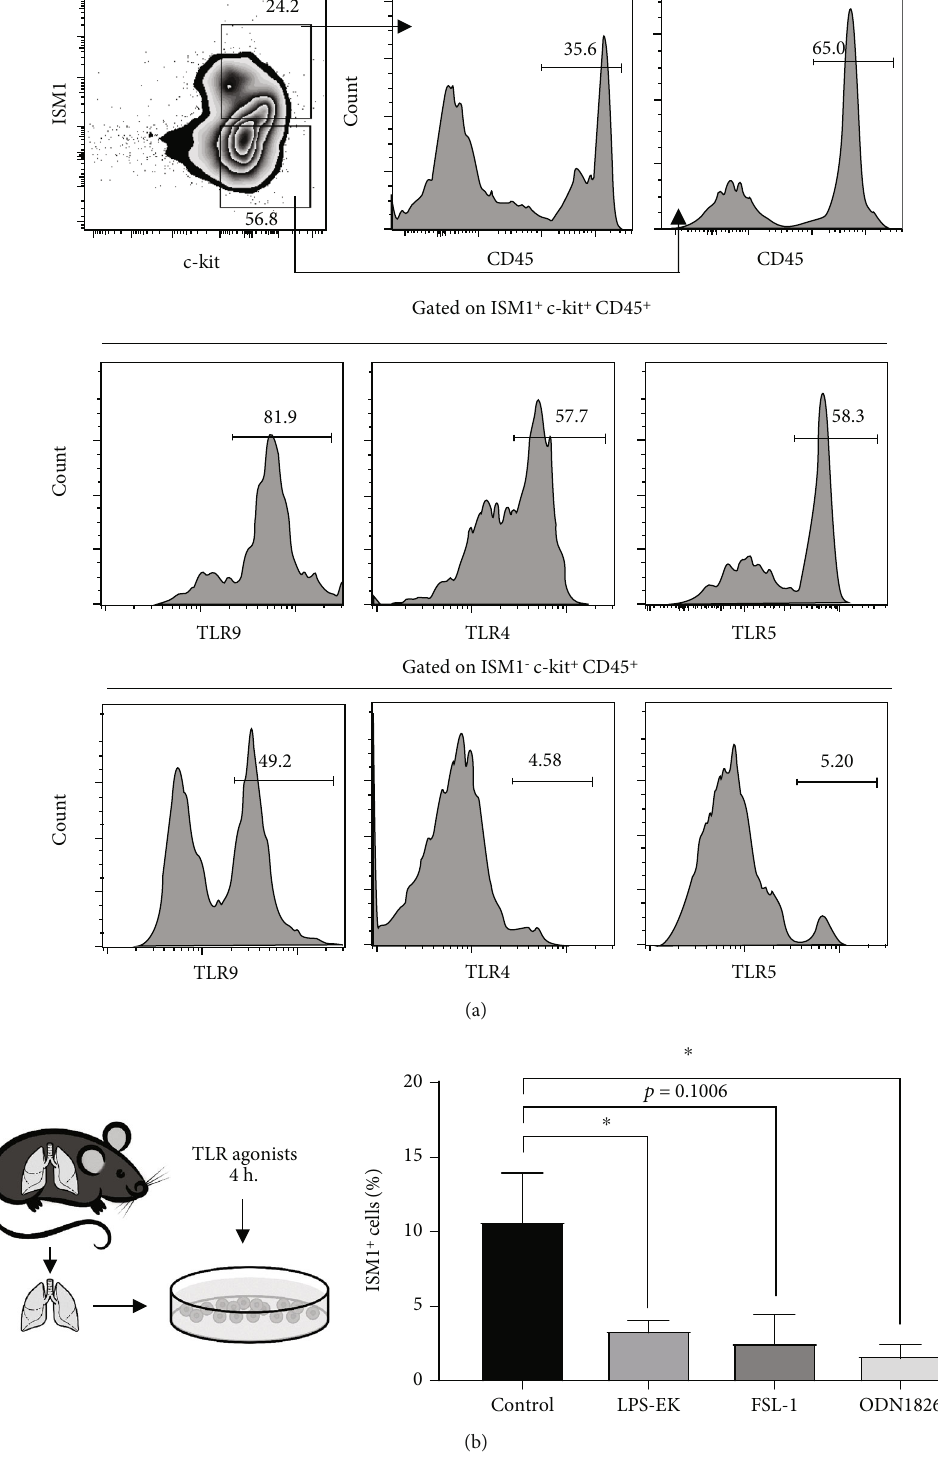
Figure 7: Lung ISM1 + progenitor-like cells express TLR9, TLR4, and TLR5. (a) Whole lung cells were stained against ISM1, c-kit, and CD45, and TLRs presence were detected. A representative experiment is shown out 3 independent experiments. (b) In vitro stimulation of lung cells with TLR9, TLR4, and TLR5 agonists; ISM1 + cells decreased after 4h of stimulation. Data are means plus SEM n = 3 independent experiments. Statistical analysis was performed by one-way ANOVA; ∗ p < 0 : 05